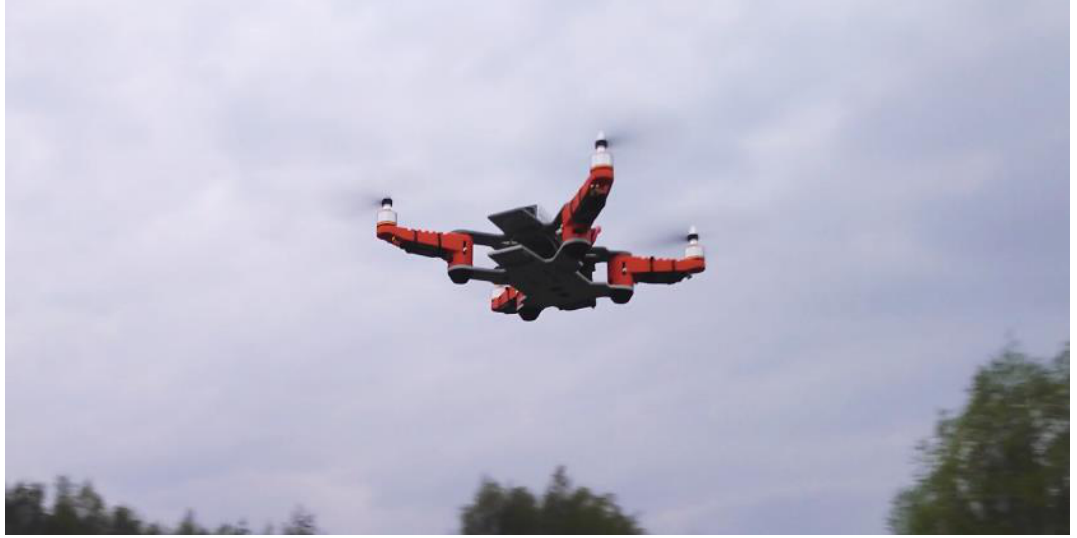
Figure 27. The quadcopter during flight.